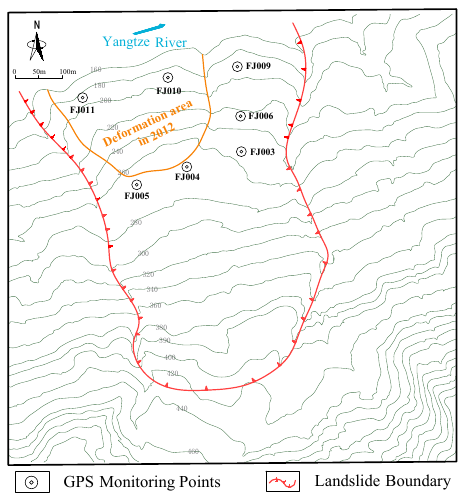
Figure 2. Schematic diagram of monitoring arrangement of the Huanglianshu